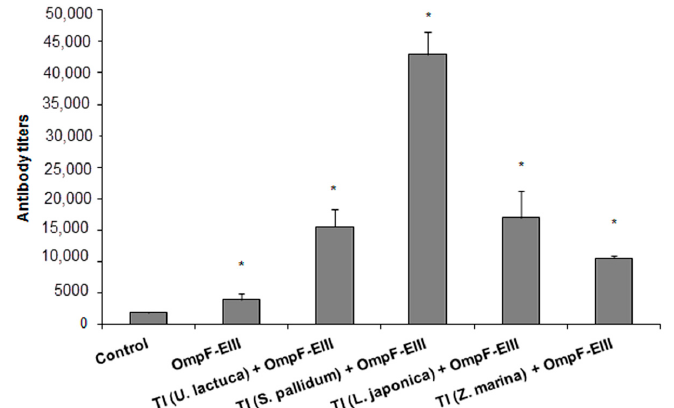
Figure 3. The content of anti-EIII antibodies in mice blood sera depending on the MGDG constituent of TI-complexes. Antibodies were evaluated by ELISA in mice blood sera after two immunizations with individual EIII-OmpF (OmpF-EIII) and OmpF-EIII incorporated in TI-complexes based on MGDG from Ulva lactuca (TI ( U. lactuca + OmpF-EIII)), Sargassum pallidum (TI ( S. pallidum + OmpF-EIII)), Laminaria japonica (TI ( L. japonica + OmpF-EIII)), or Zostera marina (TI ( Z. marina + OmpF-EIII)), respectively, at a dose of 20 µ g/mouse, administered subcutaneously at an interval of 14 days. The control group included mice immunized with PBS containing 0.125% n -octylglucoside. Each experimental group included ten mice. The experiment was terminated 28 days after the first immunization. Y -axis: The content of anti-EIII antibodies in the experimental groups. Data are expressed in titers. Bars represent mean ± SE. * p < 0.05 as compared with the OmpF-EIII.